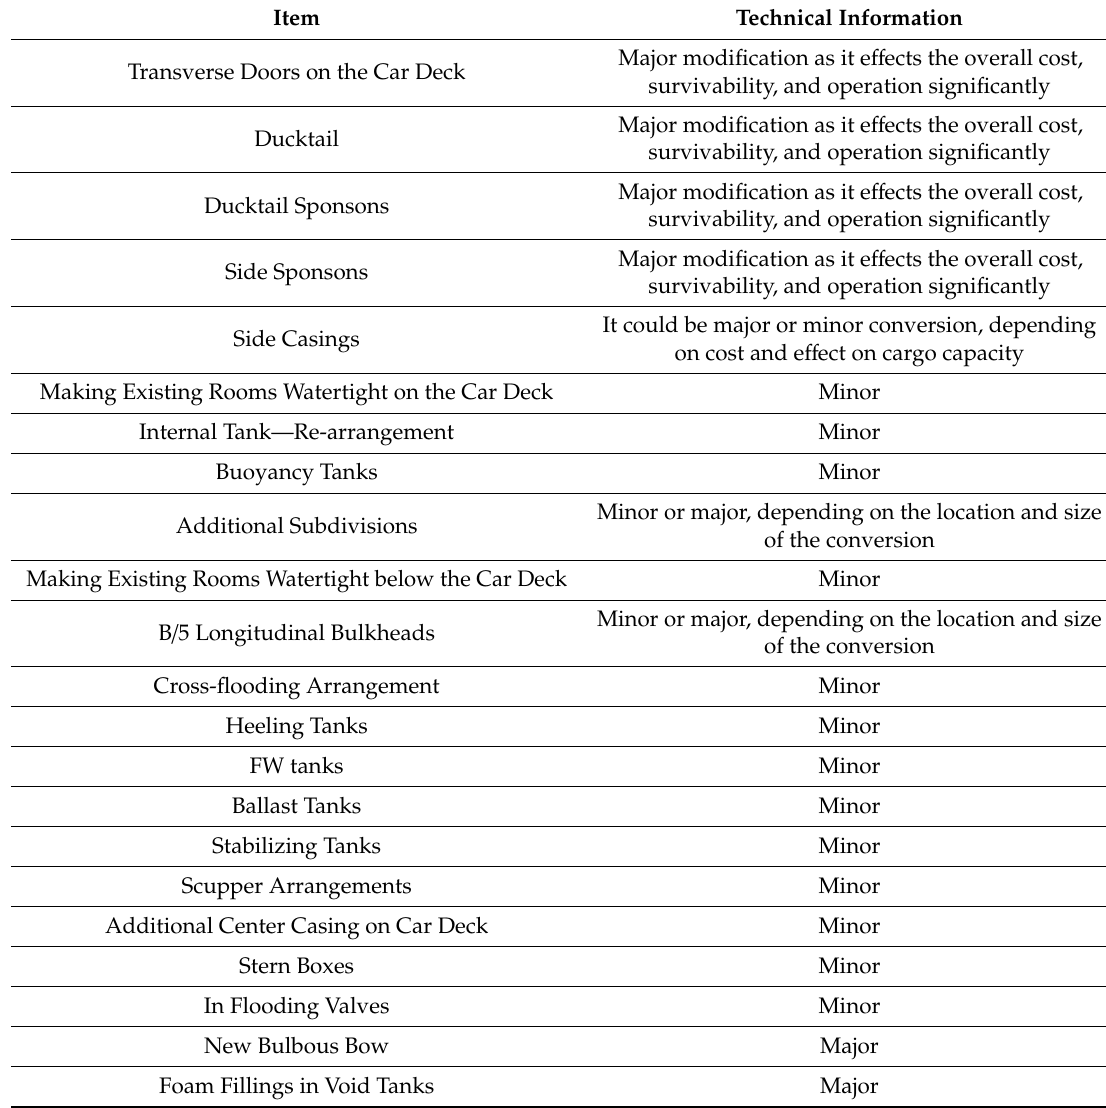
Table 3. Technical information on retrofitted Ro-Ro passenger ships for Stockholm Agreement compliance